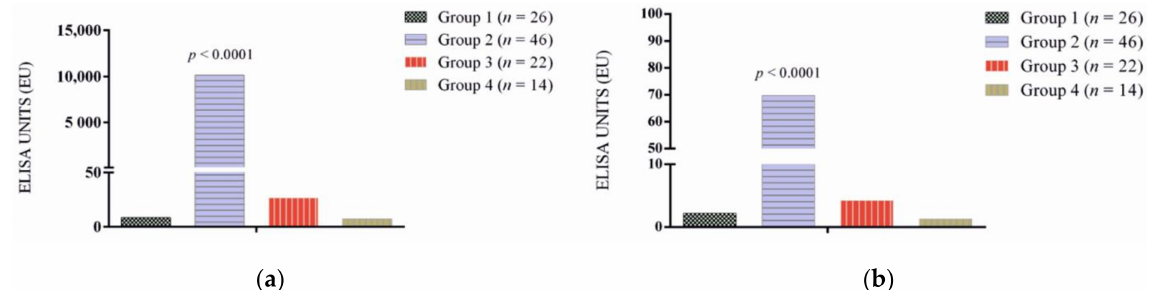
Figure 1. Specific ( a ) L infantum and ( b ) rKMP11 antibodies levels in apparently healthy non-infected dogs from a low endemicity area, Asturias, Spain (Group 1), sick dogs from Catalonia, Spain (Group 2) apparently healthy Ibizan hounds from a high endemicity area, Mallorca, Spain (Group 3) and apparently healthy dogs from a high endemicity area, Bari, Italy (Group 4).